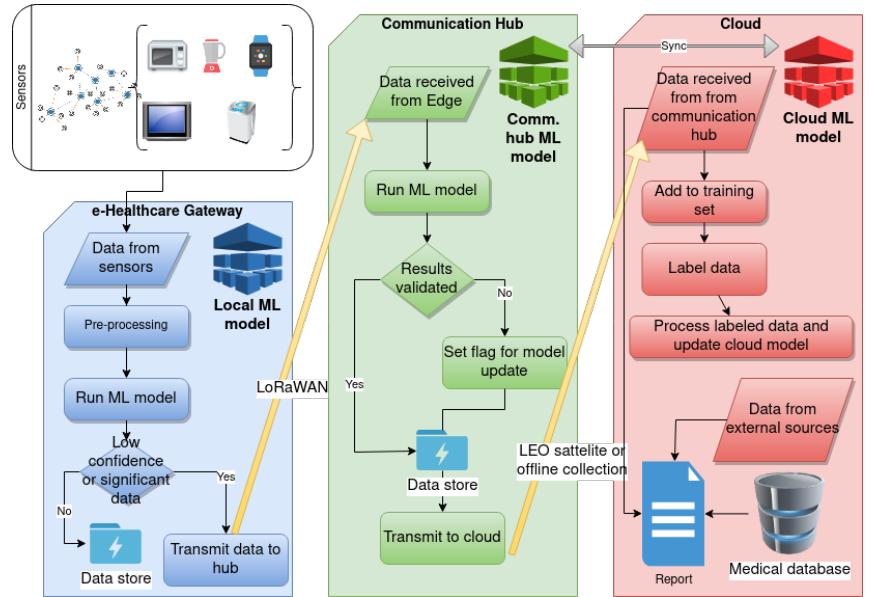
Figure 3. Machine learning workflow using Fog based